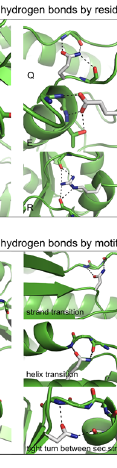
Figure 7 . Specific examples of hydrogen bonds removed by AvNAPSA supercharge . In AvNAPSA designs, wild-type surface residues forming hydrogen bonds can be mutated (white sticks show the native side chain). A) Mutation of surface NQ/DE/RK residues can lead to loss of hydrogen bonds. B) Common sidechain-backbone hydrogen bonding motifs at protein surfaces mediate direct interaction with secondary structure elements and interaction with regions that transition between secondary structure elements. N and Q residues can act as both donor and acceptor, illustrating the risk of automated N to D and Q to E